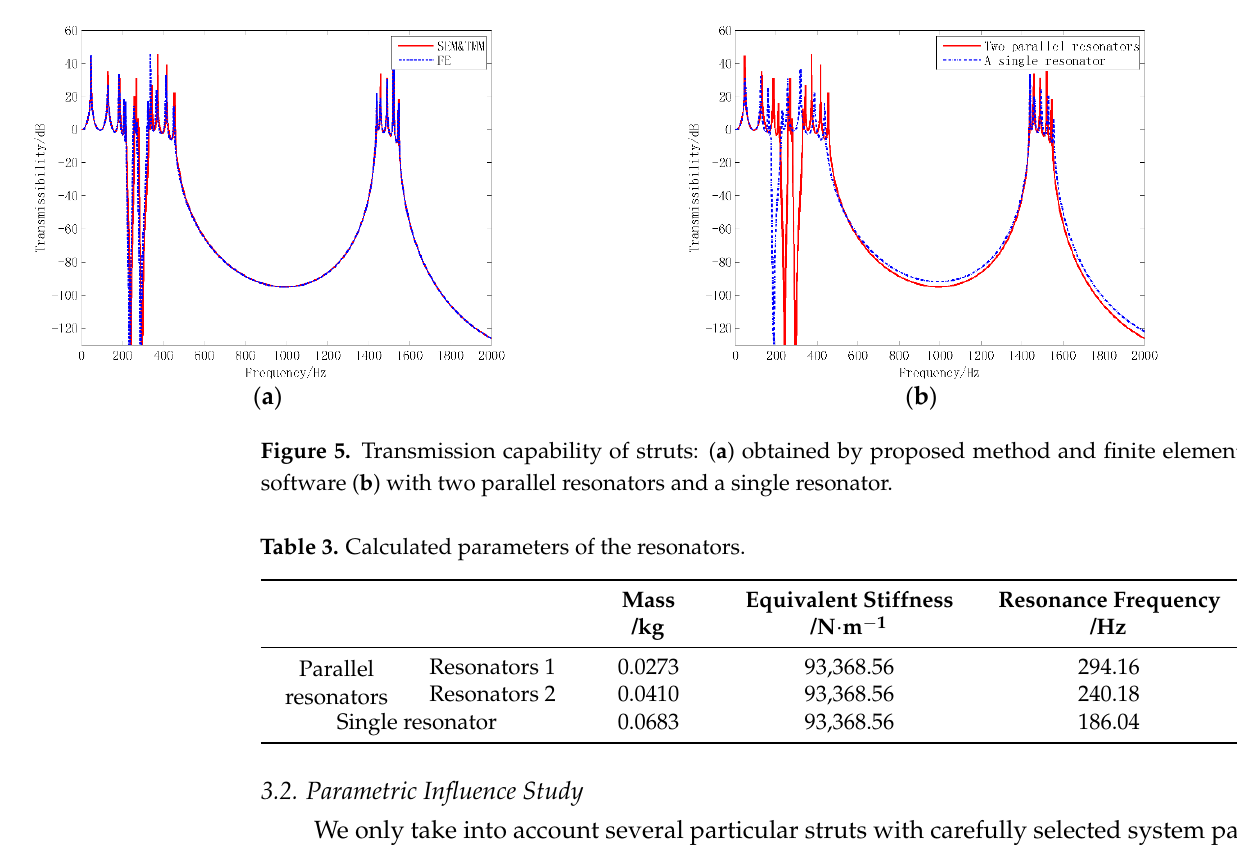
Table 3. Calculated parameters of the resonators.